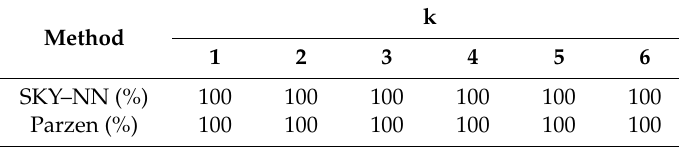
Table 20. Opposite skyline on the synthetic Dataset III.